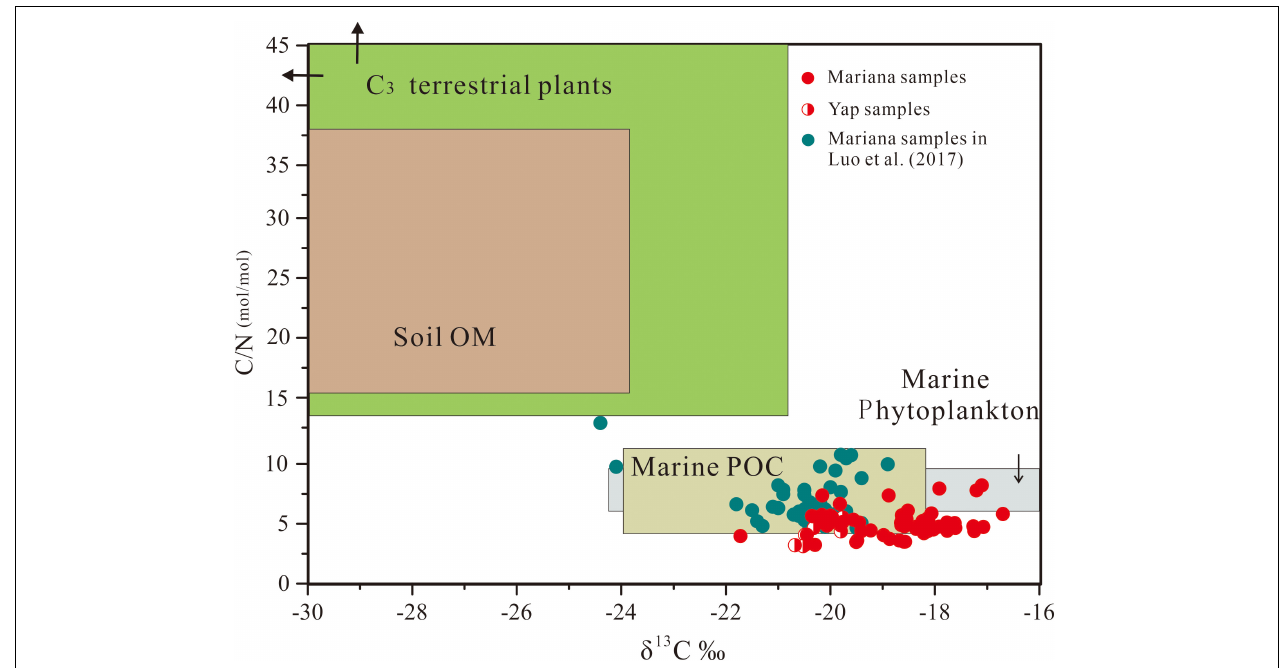
FIGURE 3 | Relationship between δ 13 C of TOC and molar C/N ratios of organic matter. The domains of marine particle organic matter (Marine POC), marine phytoplankton, soil organic matter (Soil OM), and C3 vascular plant are based on Goni et al., 2008; Khan et al., 2015 and references therein. The data of blue-green points in this figure are derived from Luo et al.,